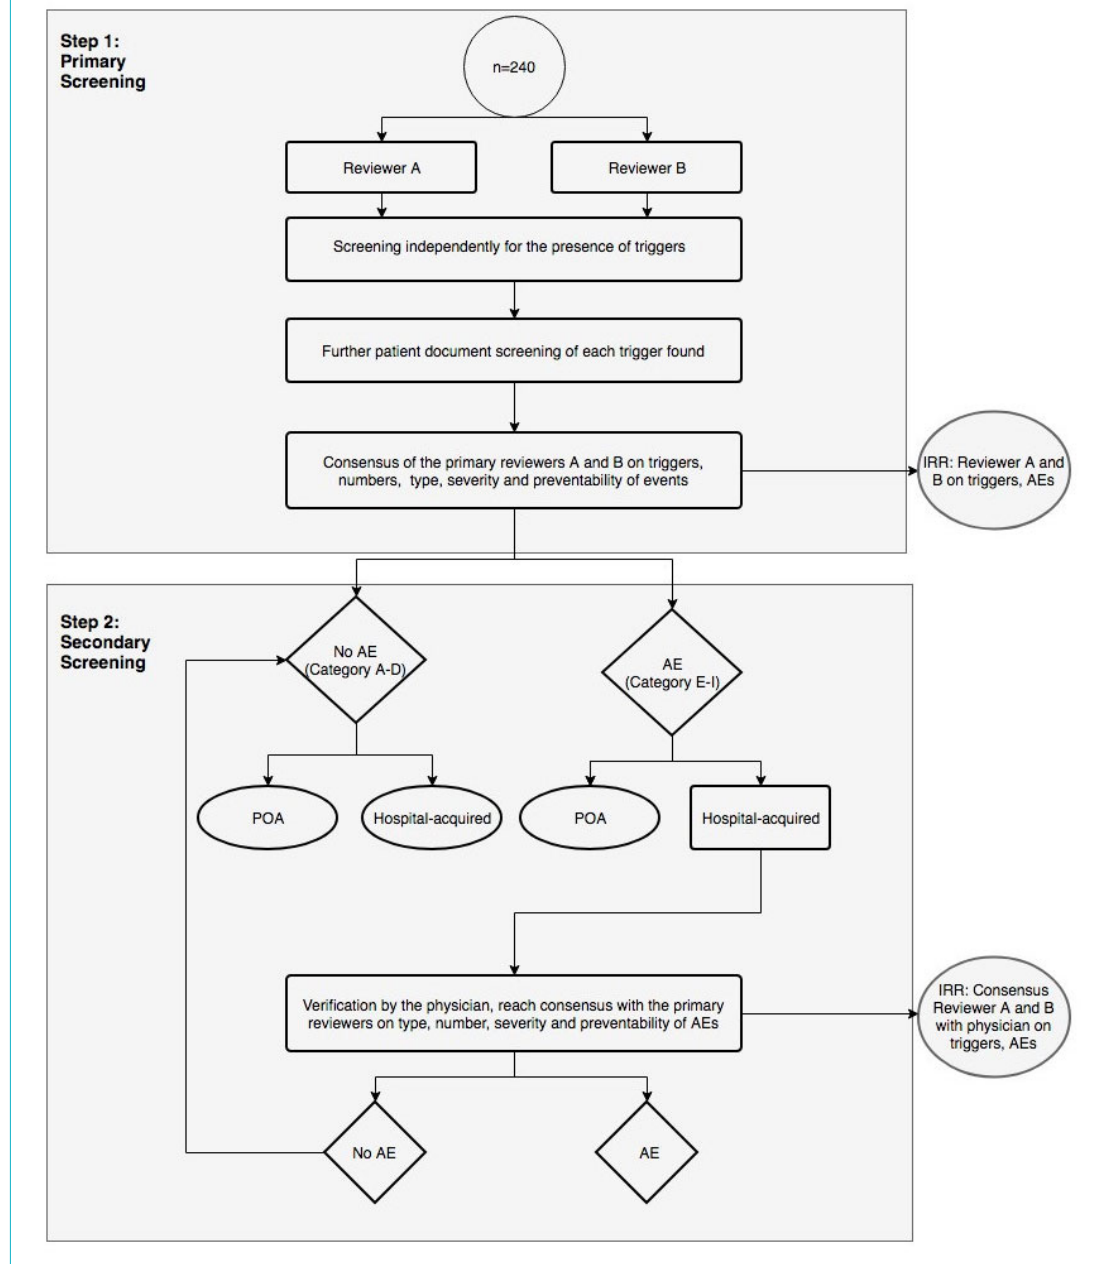
Figure 1: Screening procedure for the identification of adverse events. Two nurses review each electronic health record independently within a maximum time limit of 20 minutes. They compare and discuss their findings and reach consensus. The physician afterwards verifies the find- ings of the in-hospital AEs (harm E–I).AE = adverse event; IRR = interrater reliability; POA = present on admissionThe National Coordinating Council for Medication Error Reporting and Prevention Index (NCC MERP) categories: A–D = no harm to patients, E–I = harm to